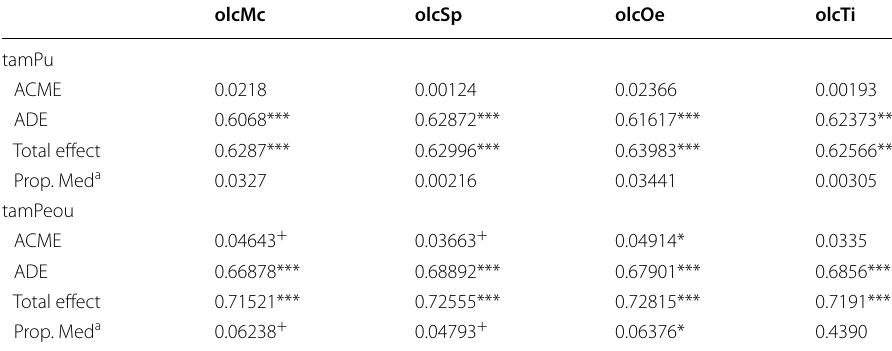
ACME average causal mediation, ADE average direct